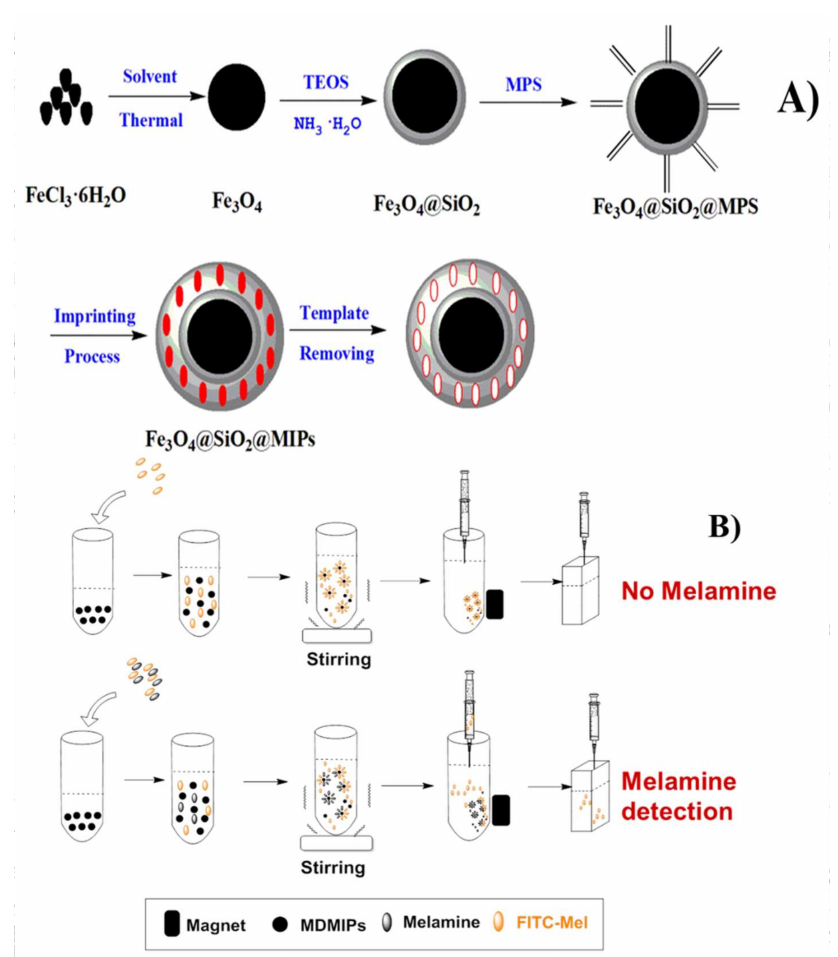
Figure 1. ( A ) Procedure for MDMIP preparation and ( B ) mechanism of competitive fluorescence assay of